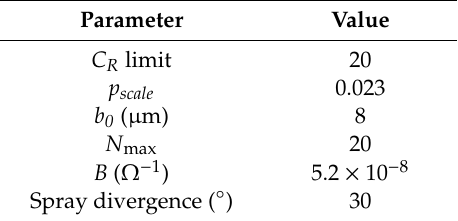
Figure 23. Experimental and modeled VI curves for positive and negative polarity operation of the conical porous borosilicate emitter impregnated with EMI ‐ TFSI. Table 12. Benchmarking parameters applied in ESPET models for positive emissions.